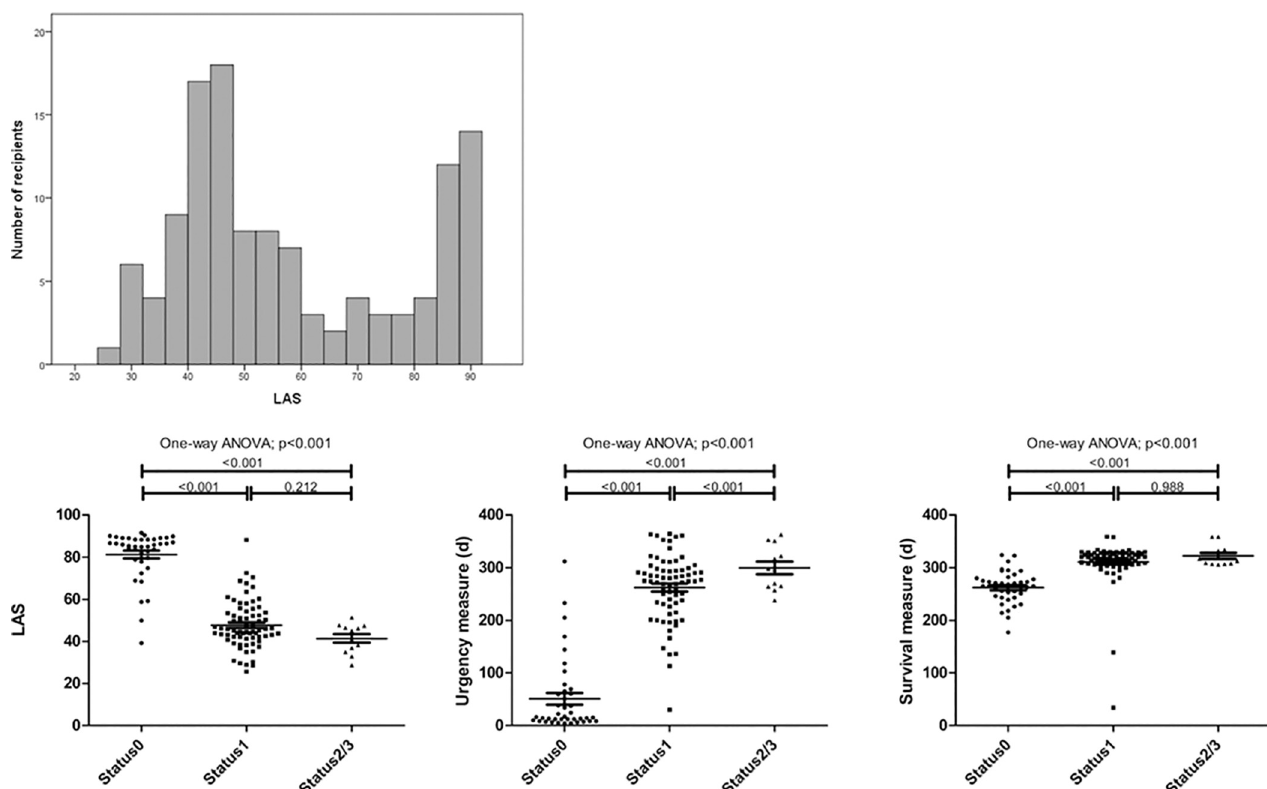
Fig 3. Distributions of lung allocation scores among patients who received lung transplants. Abbreviations: ANOVA, analysis of variance; LAS, lung allocation score.